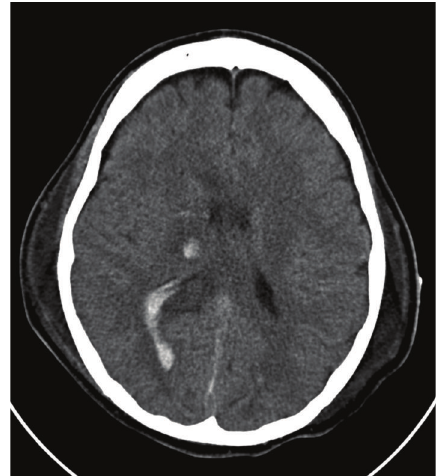
Figure 2: CT of head demonstrates intraventricular and intrapa- renchymal